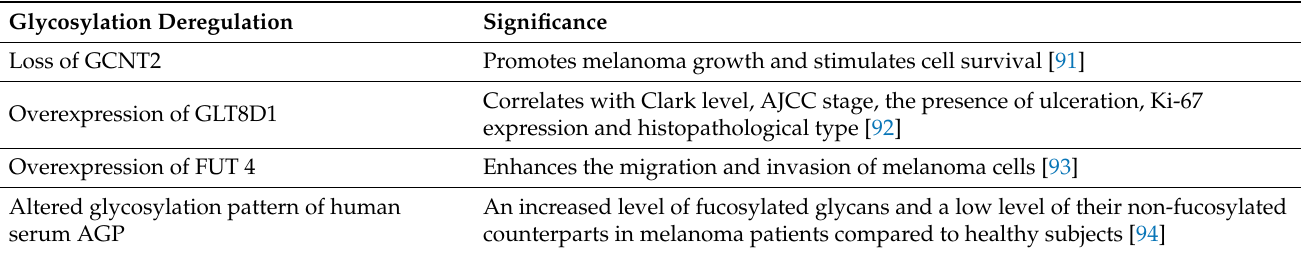
Table 2. Novel markers of aberrant glycosylation in